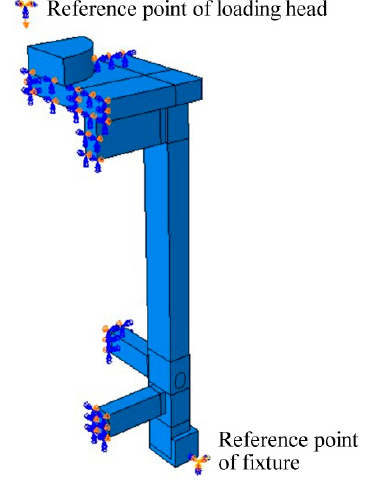
Figure 7. A quarter finite element model of chair.